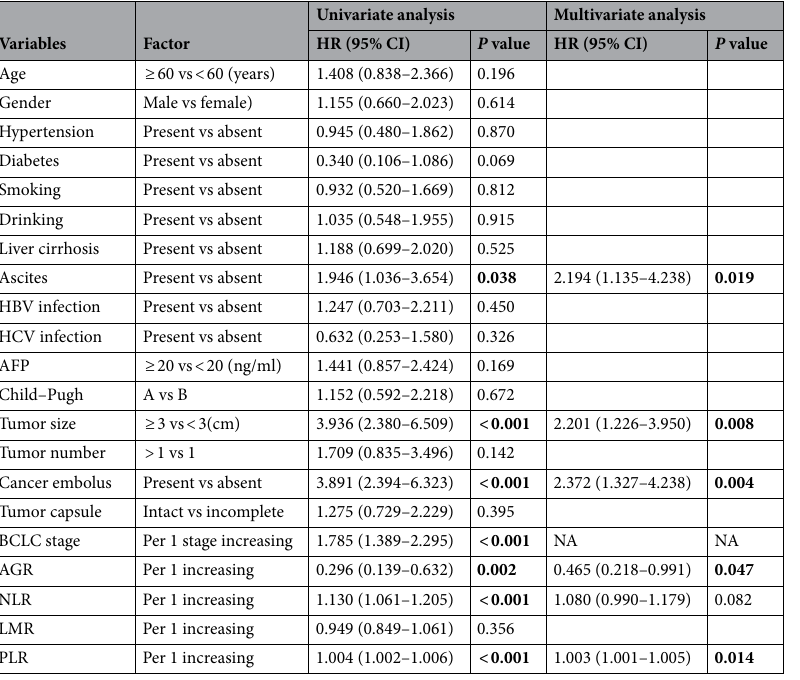
Table 3. Univariate and multivariate Cox proportional hazards regression analyses of overall survival in the training cohort. P value of less than 0.050 was considered to indicate significant difference. AFP alpha- fetoprotein, HBV hepatitis B virus, HCV hepatitis C virus, AGR albumin to globulin ratio, NLR neutrophil to lymphocyte ratio, PLR platelet to lymphocyte ratio, LMR lymphocyte to monocyte ratio, HR hazard ratio, CI confidence